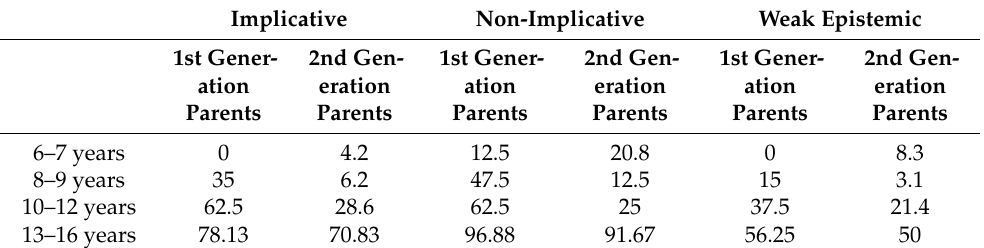
Table 2. Accuracy rate in the subjunctive conditions per parent profile and age group (in %) (from (Flores et al.